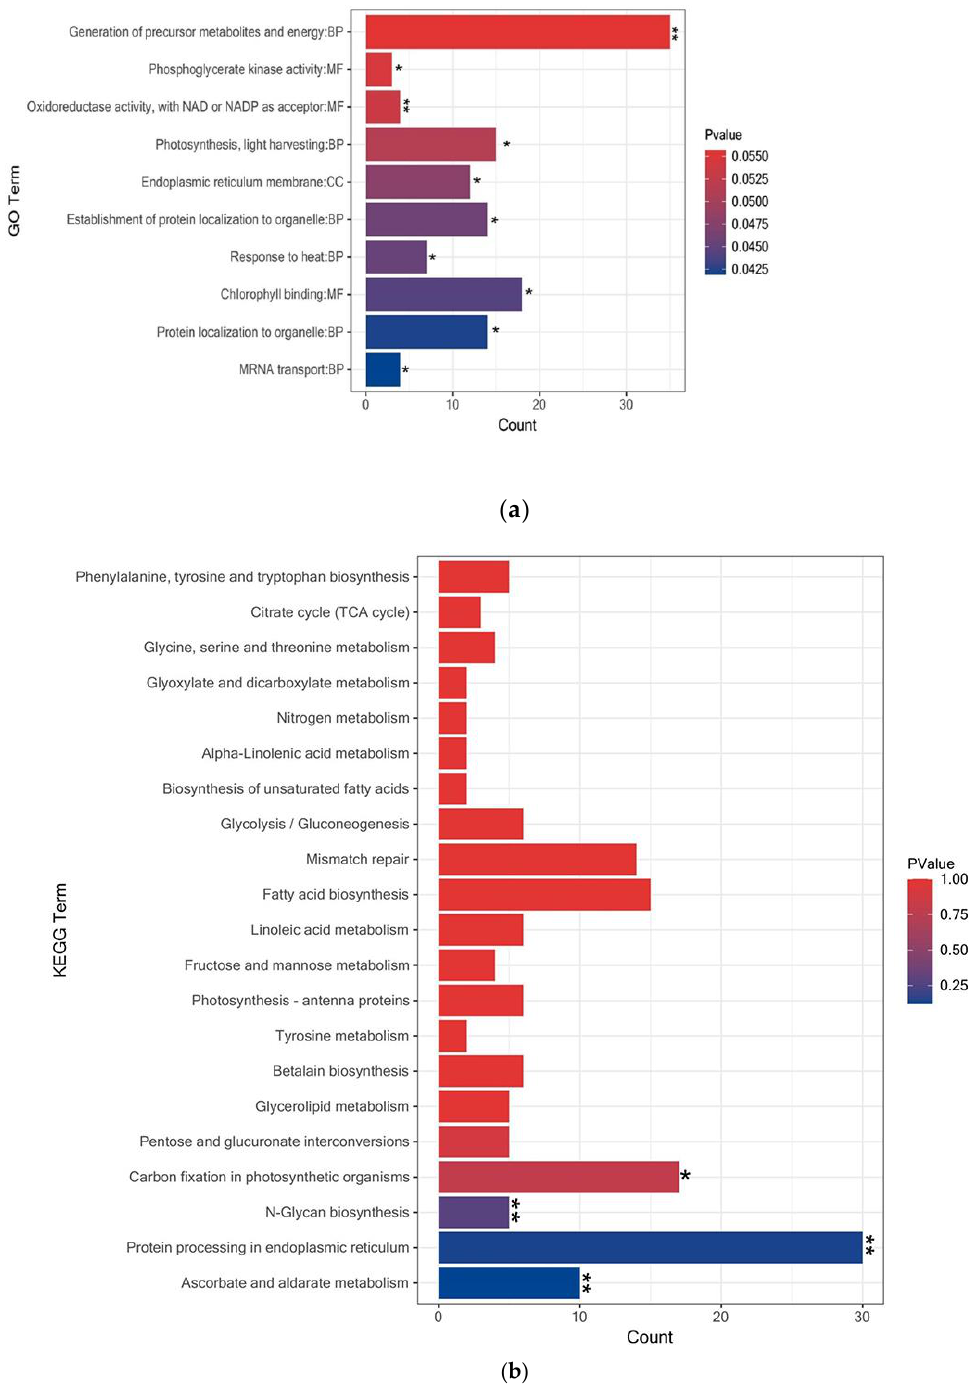
Figure 3. Enrichment analysis of the DAPs DAPs: ( a ) GO function of enrichment analysis of First/Fifth harvest. ( b ) DAPs KEGG function of enrichment analysis of First/Fifth harvest. (* p < 0.05, ** p <